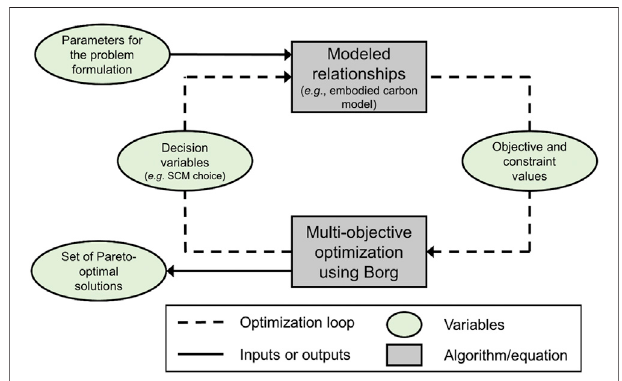
FIGURE 1 | Conceptualization of the simulation-optimization framework for analyzing each scenario. The Borg MOEA is coupled with the simulation of concrete properties to fi nd Pareto-optimal mixture designs for different